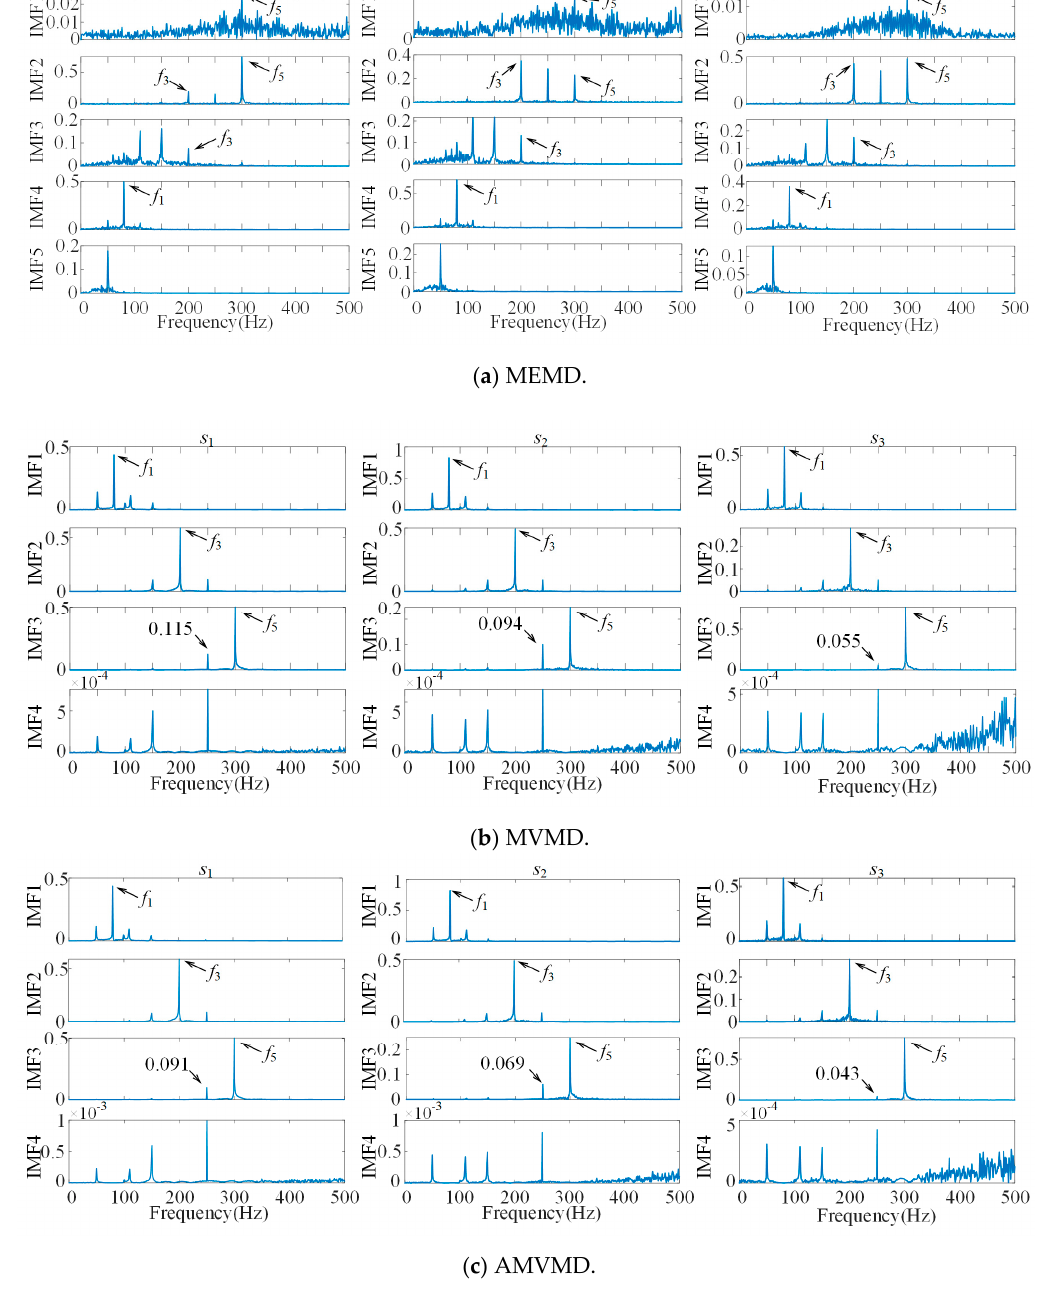
Figure 3. Effect comparison of three methods.